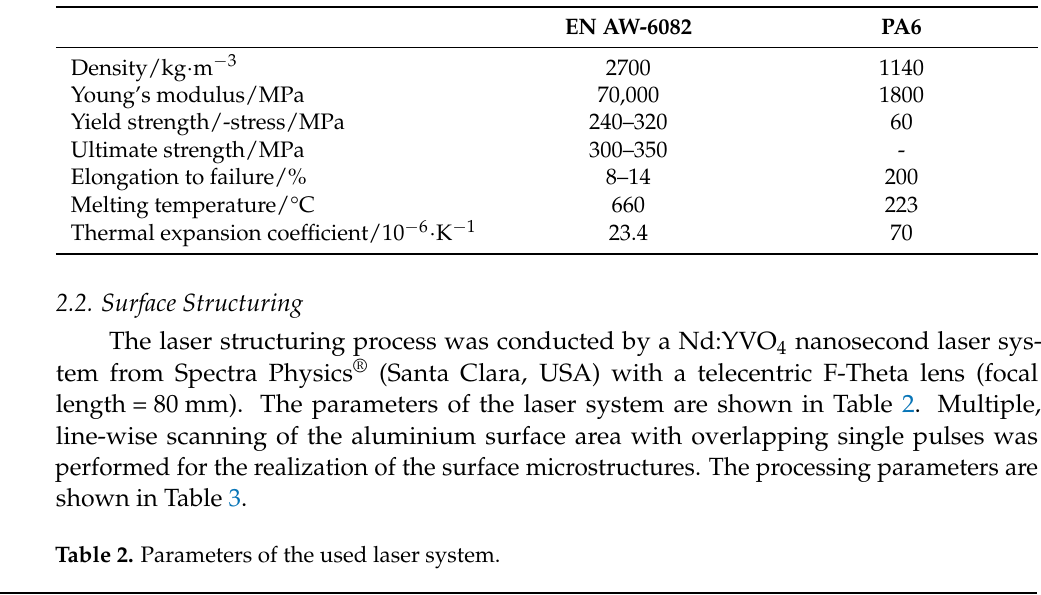
Table 1. Supplier specifications of the used materials, PA6 in moist condition according to ISO 1110.